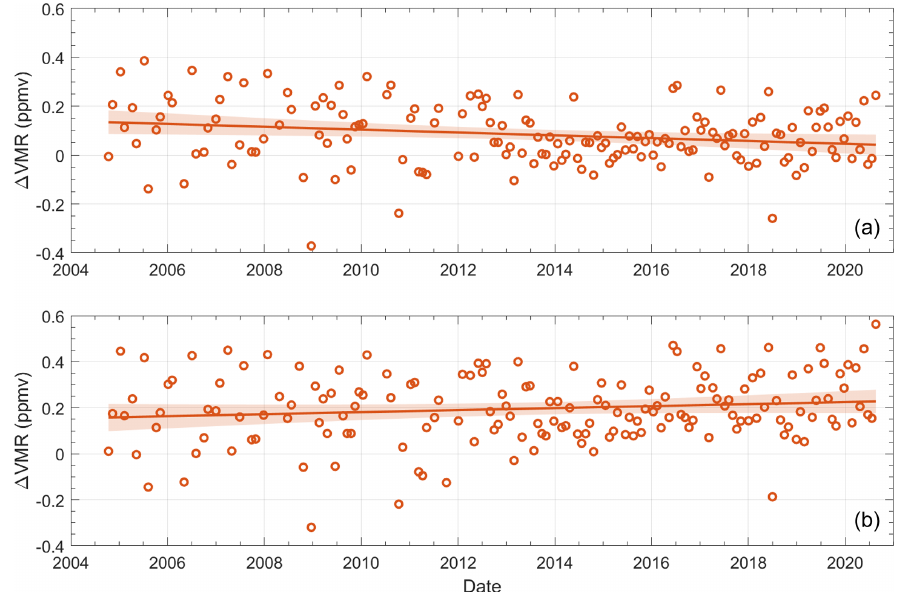
Figure 6. Linear fits (lines) to the 30d average differences (circles) between ACE-FTS and MLS at an altitude of 42.5km for (a) ACE-FTS v3.6 and (b) ACE-FTS v4.1. Shaded areas represent the 99% confidence